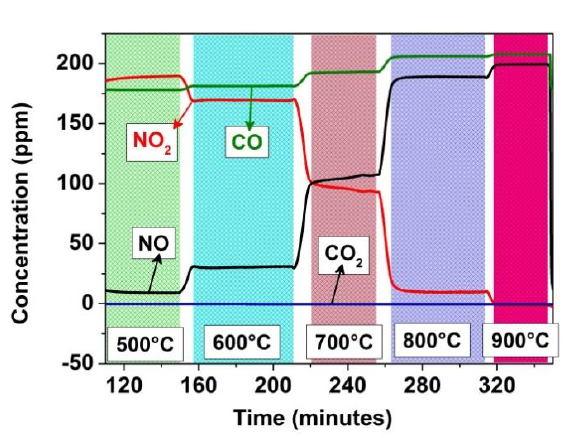
Figure 5. Temperature-dependent conversion of NO 2 to NO in the empty sensor test chamber, with no visible conversion of CO to CO 2 .